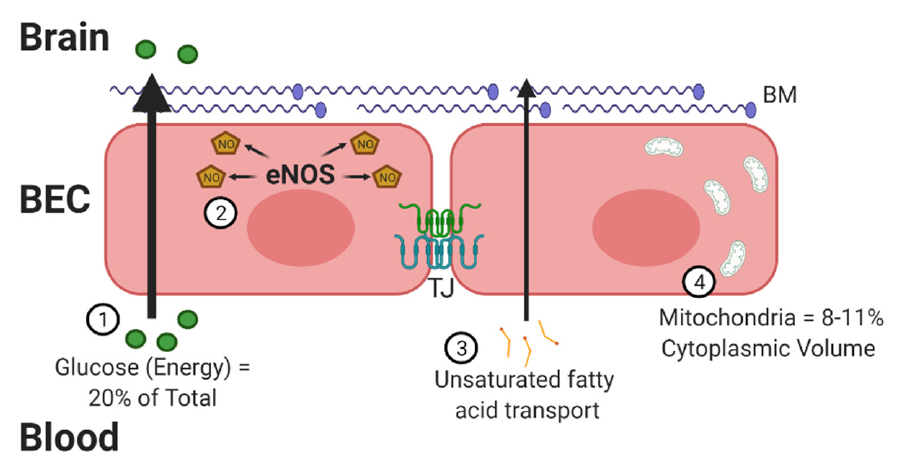
Figure 1. The blood–brain barrier (BBB) and oxidative stress. There are 4 distinct ways brain endothelial cells (BECs) are at a greater exposure to oxidative factors. First, these cells must transport high levels of glucose into the brain for energy. Glucose must be metabolized to energy-utilizing substrates within mitochondria, generating free oxygen radicals. Second, BECs generate high levels of nitric oxide (NO) through endothelial nitric oxide synthase (eNOS), required for intracellular signaling and regulation of vascular tone. Third, BECs must transport dietary lipids and fatty acids into the brain as an alternative source of energy and signaling. This creates an increased opportunity for the generation of lipid peroxidation. Lastly, BECs contain a greater number of mitochondria compared to peripheral endothelial cells. Mitochondria are the primary source of reactive species, including superoxide. In all, BECs require a critical counter-regulatory process to combat the oxidative factors in order to maintain a functioning BBB with preserved tight junction (TJ) proteins and basement membrane (BM). Figure generated using BioRender.